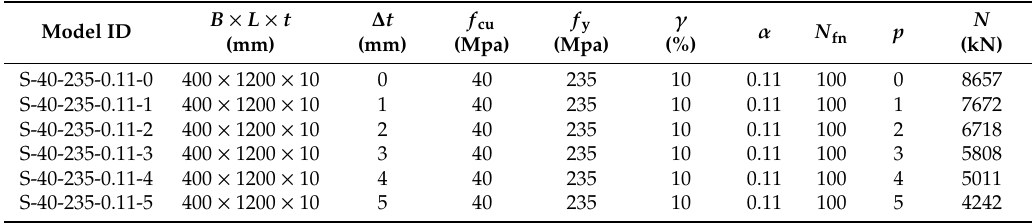
Table 3. Main design parameters of the